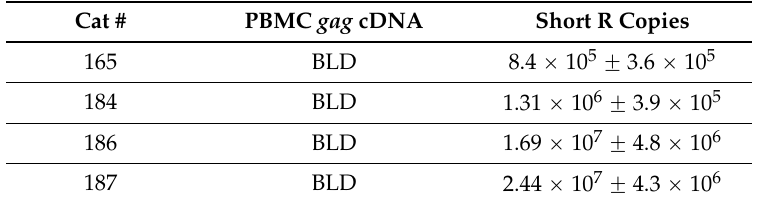
the limit of detection.